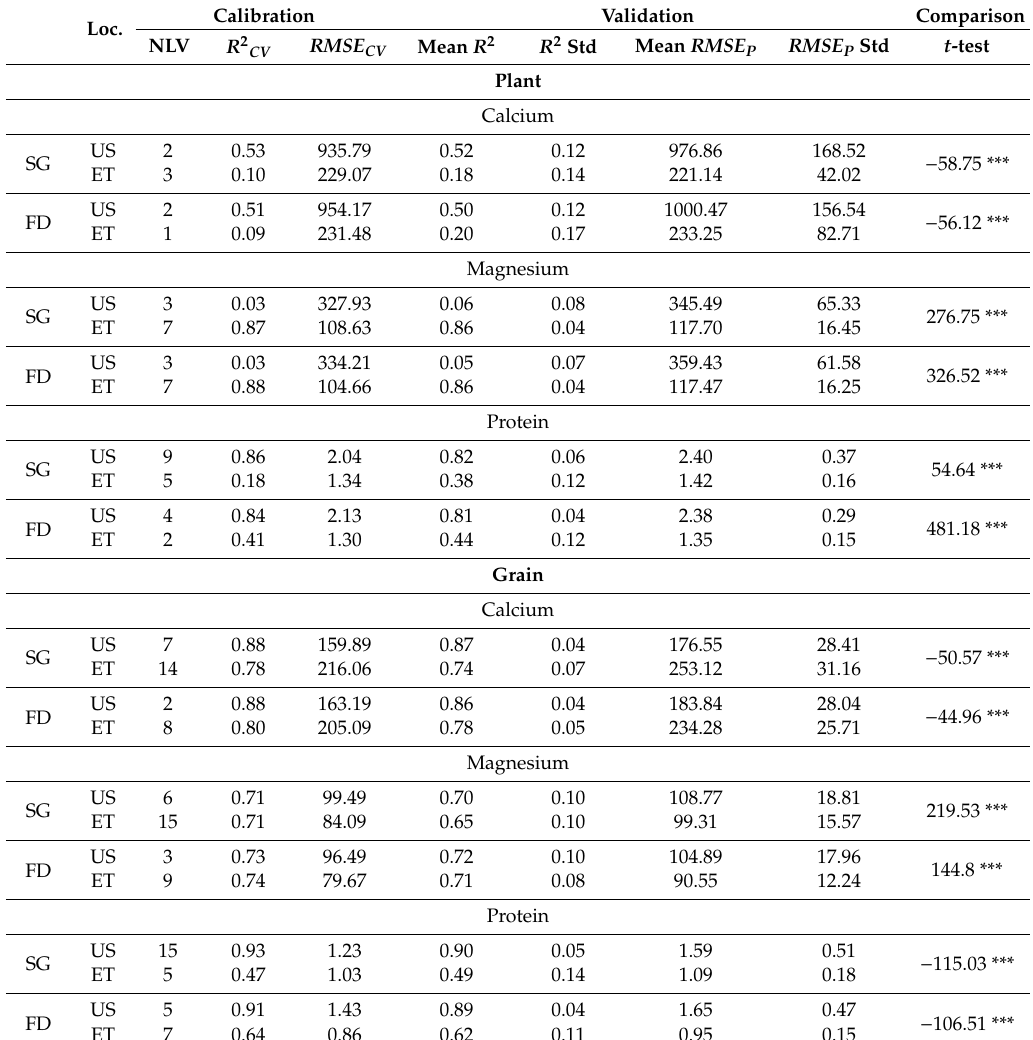
Table 3. Partial least squares (PLS) regression and t-test results for the full spectrum model (PLS-Full) for plant and grain. SG: Savitsky–Golay; FD: First derivative; NLV: Number of latent variables; std: Standard